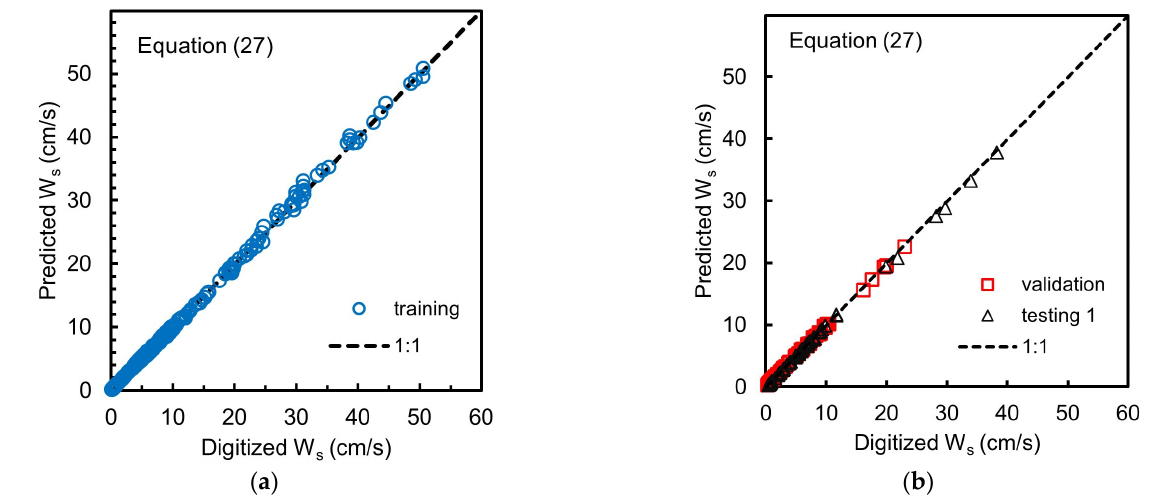
Figure 7. Scattering plot for results of model training ( a ); validation and testing 1 ( b ) for simplified ANN5, Equation (27).